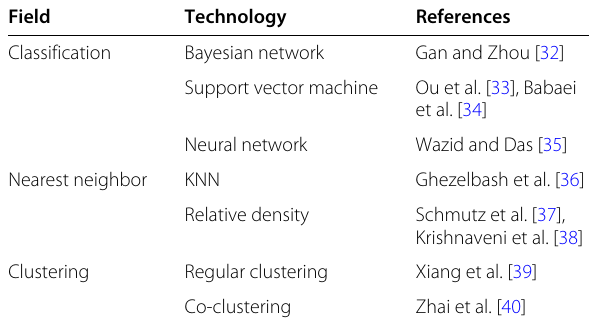
Table 1 Definitions of anomalies and anomaly detection Table 2 Techniques for anomaly